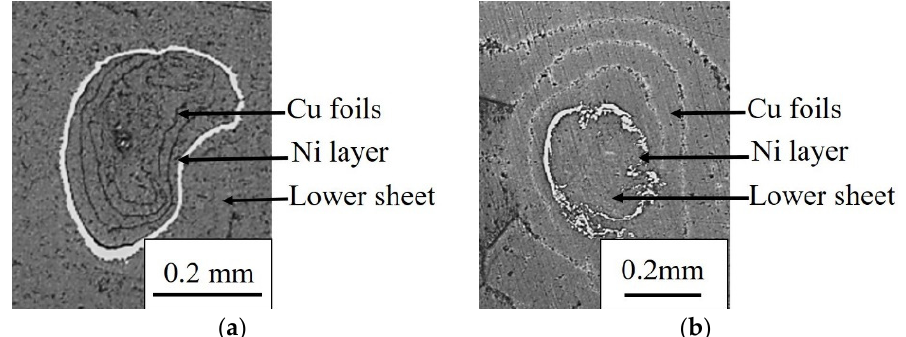
Figure 14. Optical micrographs of cross sections from the foil side around the region in which the tool edge penetrated near the bonding interface; ( a ) when using the K-type tool and ( b ) when using the C-type tool.